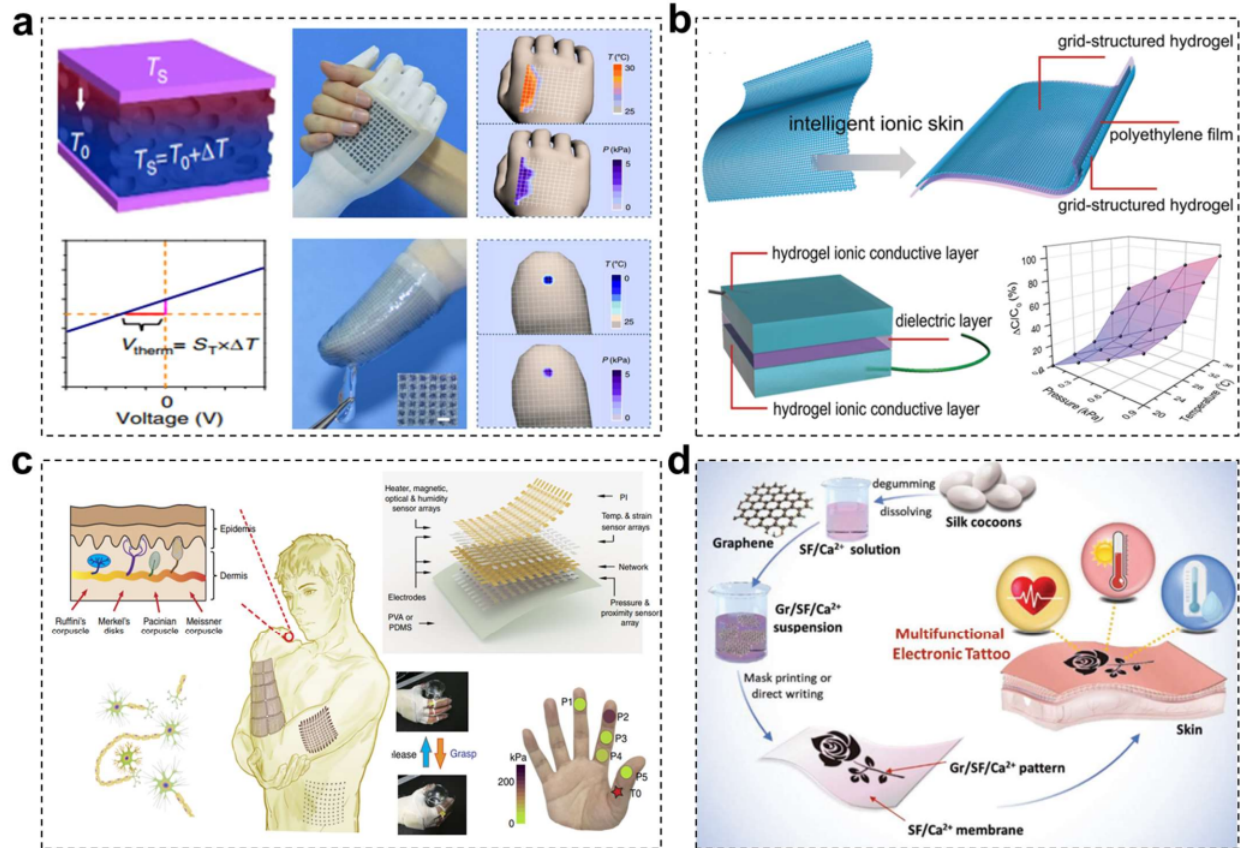
Figure 2. ( a ) Schematic illustration of sensing mechanism under a coupled temperature and pressure stimuli. Digital photos of a prosthetic hand arm in contact with an adult woman and an e-finger touching an ice cube. The graphs display the corresponding temperature and pressure mapping signal profiles of the prosthetic hand. Reprinted with permission from ref. [75]. Copyright 2015 Springer Nature. ( b ) Schematic illustration of an ionic skin fabricated from the printed hydrogels and a capacitive sensor device. The corresponding capacitive response of the hydrogel sensor upon applying pressure and temperature. Reprinted with permission from ref. [80]. Copyright 2017 Royal Society of Chemistry. ( c ) Schematic illustration of SCMN conforming to the surface of human skins. Schematic layout of an integrated sensor array with eight functions. The images show the operations of the intelligent prosthetic hand to grasp and release water and the corresponding sensor distribution. Reprinted with permission from ref. [95]. Copyright 2018, Springer Nature. ( d ) Schematic illustration of the fabrication process of multifunctional Gr/SF/Ca 2+ E-tattoo. Reproduced with permission [97]. Copyright 2019,